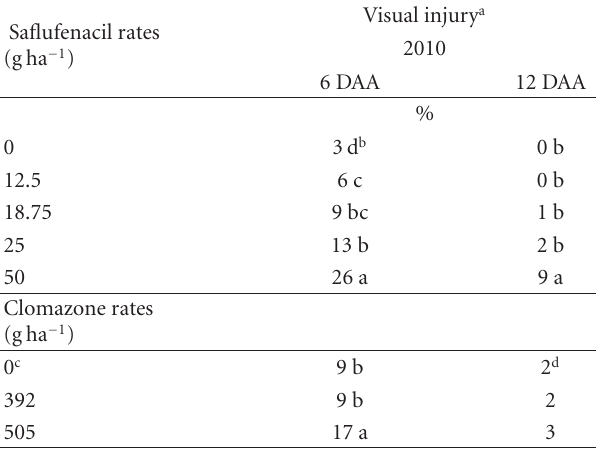
Table 5: Rice ( Orza sativa L.) visible injury at 6 and 12 days after application (DAA) in response to postemergence application (4- to 6-leaf stage, V4-V6) of saflufenacil following preemergence application of clomazone. Saflufenacil results were averaged across clomazone rates, and clomazone results were averaged across saflufenacil